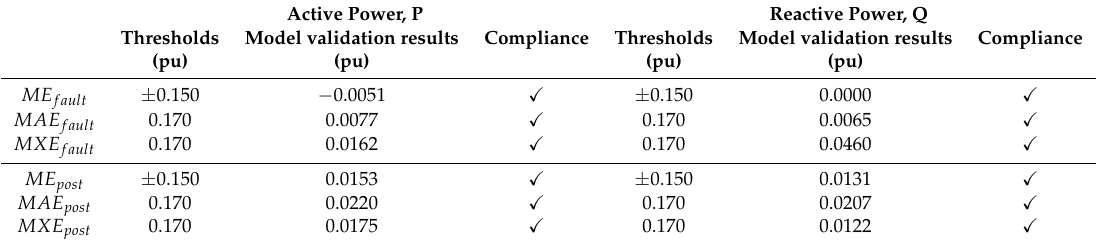
Table 5. Verification of the NTS and TG 4 validation criteria applied to the generic WT simulation t = 625